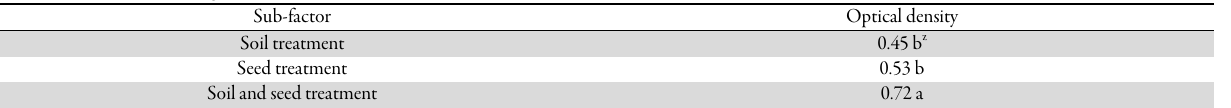
Table 2. Efficacy of the sub-factor (different application methods of T. harzianum strain 908 and F. oxysporum strain Fo47) in the suppression of BNYVV multiplication in greenhouse conditions